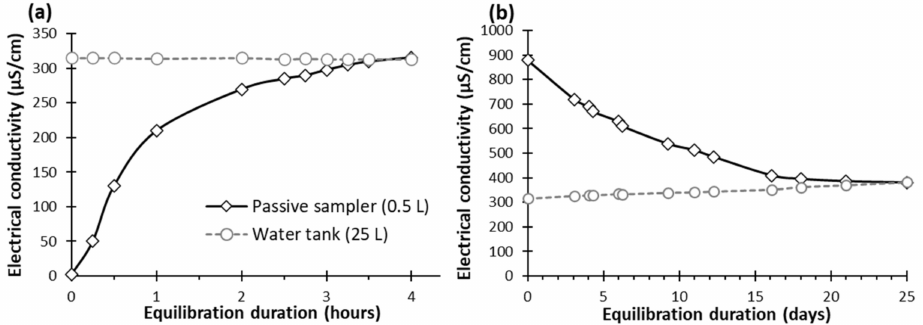
Figure 7. Equilibration results in laboratory: ( a ) conditions as implemented in situ (samplers filled with warmer distilled water), ( b ) equilibration soliciting only molecular diffusion (isothermal experience with higher mineralization into the